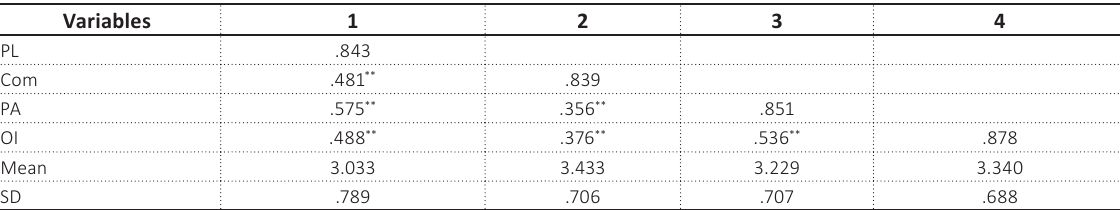
Table 2. Correlation analysis